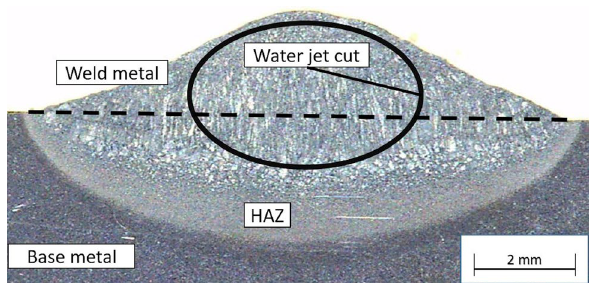
Fig. 4 Macrograph of a weld sample with a schematic representa- tion of the elliptical samples taken from the weld metal; the dotted line represents the border between the molten base metal (below), and the deposited weld metal